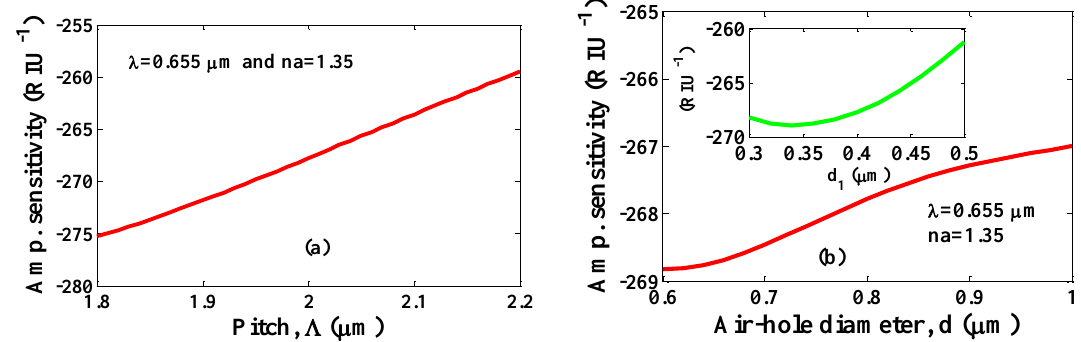
Figure 6. Variation of amplitude sensitivity due to the change of ( a ) pitch values from 1.8 to 2.2 μm and ( b ) air-hole diameter, d from 0.6 to 1 μm and d 1 from 0.3 to 0.5 μm at a fixed wavelength of 0.655 μm. A good sensor should have high linearity response. The linear fitting of the resonance wavelength with varying analyte RI values from 1.33 to 1.36 is shown in Figure 7. The regression equation of the linear line fitting is given by Y = 1.82 X − 1.825, where Y indicates the resonance wavelength and X indicates analyte RI. The R-square value for the linear line fitting is 0.9953, which indicates very good linearity. Due to good line fitting characteristics, the proposed sensor can be implemented for practical RI detection. In practical applications, the fluctuation of input light intensity is interrupted so that the exact value of amplitude sensitivity can be obtained. Due to the change in input intensity, the amplitude sensitivity varies. The geometric parameters of the PCF determine the transmitted and reflected waves (S-parameter). In this study, we mainly focus on the transmittance of the guided mode, i.e., the evanescent field. The diameter of the air holes and pitch values determine how much the evanescent field propagates towards the metal interface. In the case of the proposed PCF, the central air hole is required to prohibit the light wave centered in the core, which could reduce the chances of reaching the metal interface. On the other hand, d 1 is kept as low as possible since smaller air holes provide enough space to guide the evanescent field. Thus, the transmittance of the evanescent field